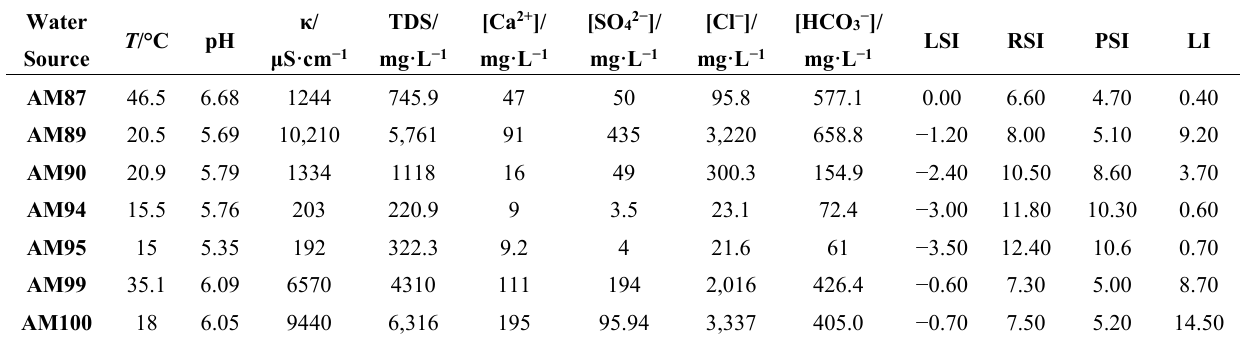
Table 3. Temperature, pH, conductivity ( κ ), total dissolved solids (TDS) and major element composition of mineral water from drilled well (dw) discharges in the Azores archipelago according to Cruz et al. [16]. Calculation of the corresponding stability and scaling indexes, namely the Langelier Saturation Index (LSI), Ryznar Stability